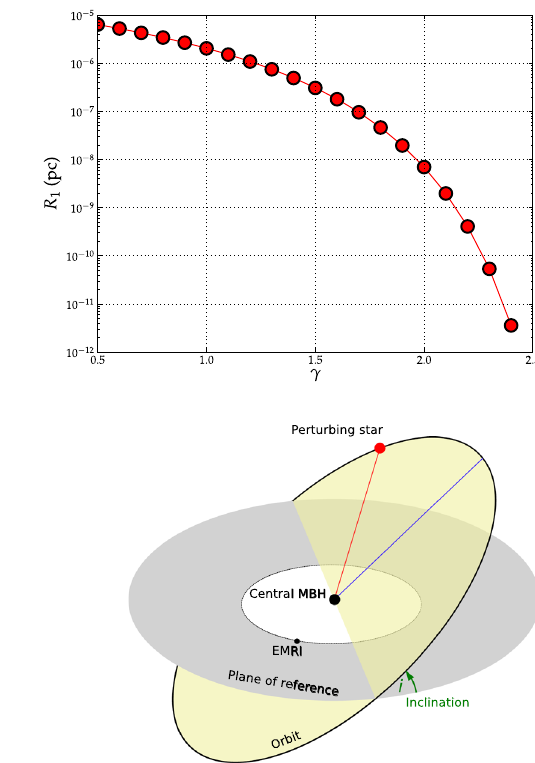
Fig. 61 Description of the scenario for the butterfly effect by Amaro-Seoane et al. (2012b) (adapted from a figure by Lucas